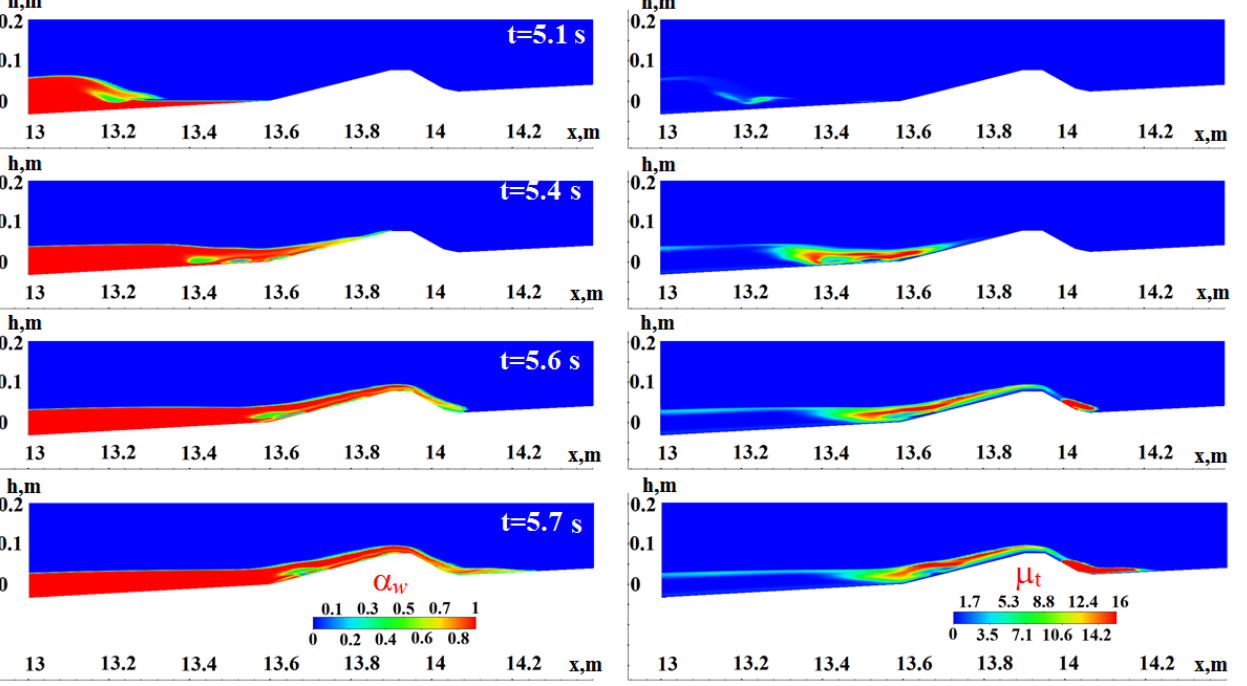
Figure 6. Time series of the free-surface position and turbulence viscosity.